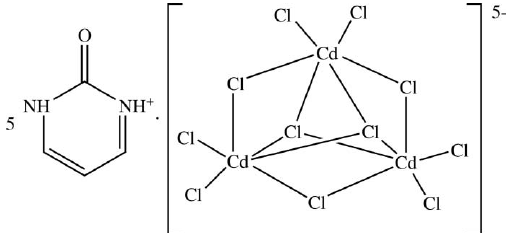
software used to prepare material for publication: SHELXTL